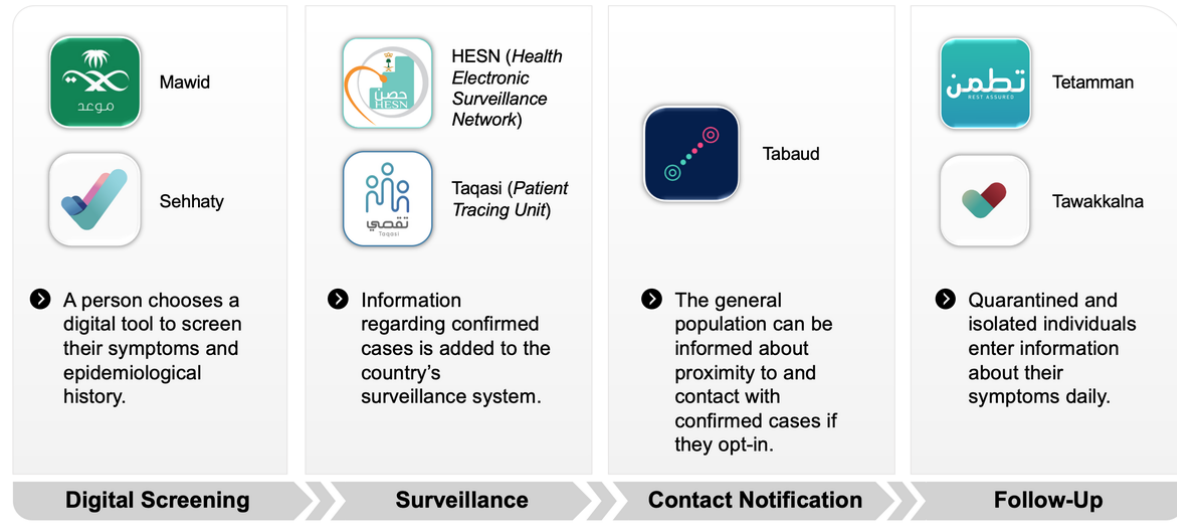
Figure 1. Examples of digital apps available for various health care domains during the COVID-19 pandemic in Saudi